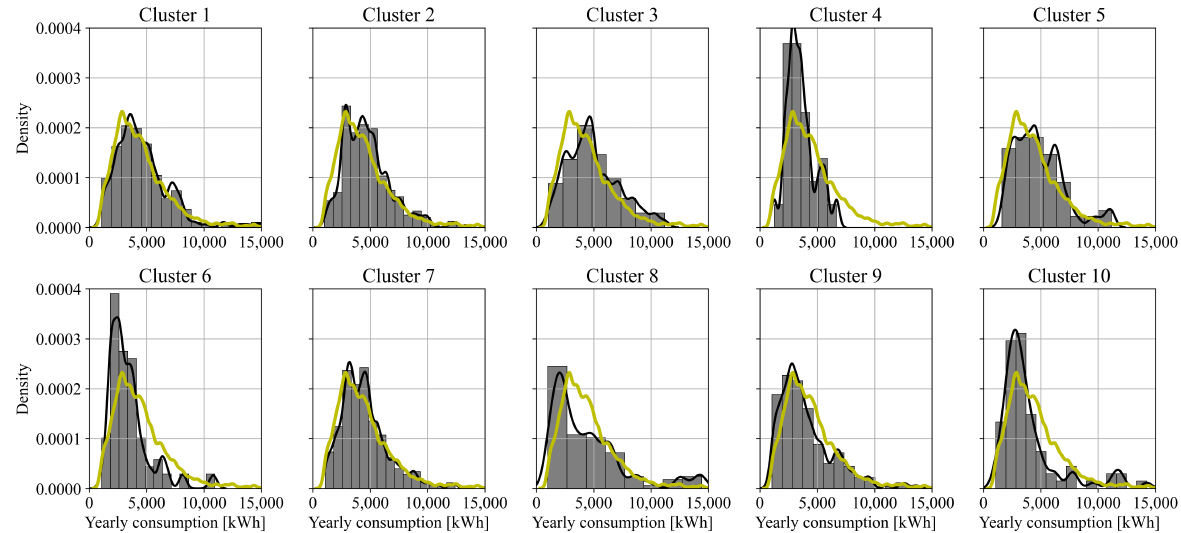
Figure 9. Density histograms with shared y-axes, displaying the distribution of the yearly consumption of the individual consumers assigned to each of the 10 considered clusters. The black plot denotes the density for the individual cluster, while the plot in yellow indicates the density of the full